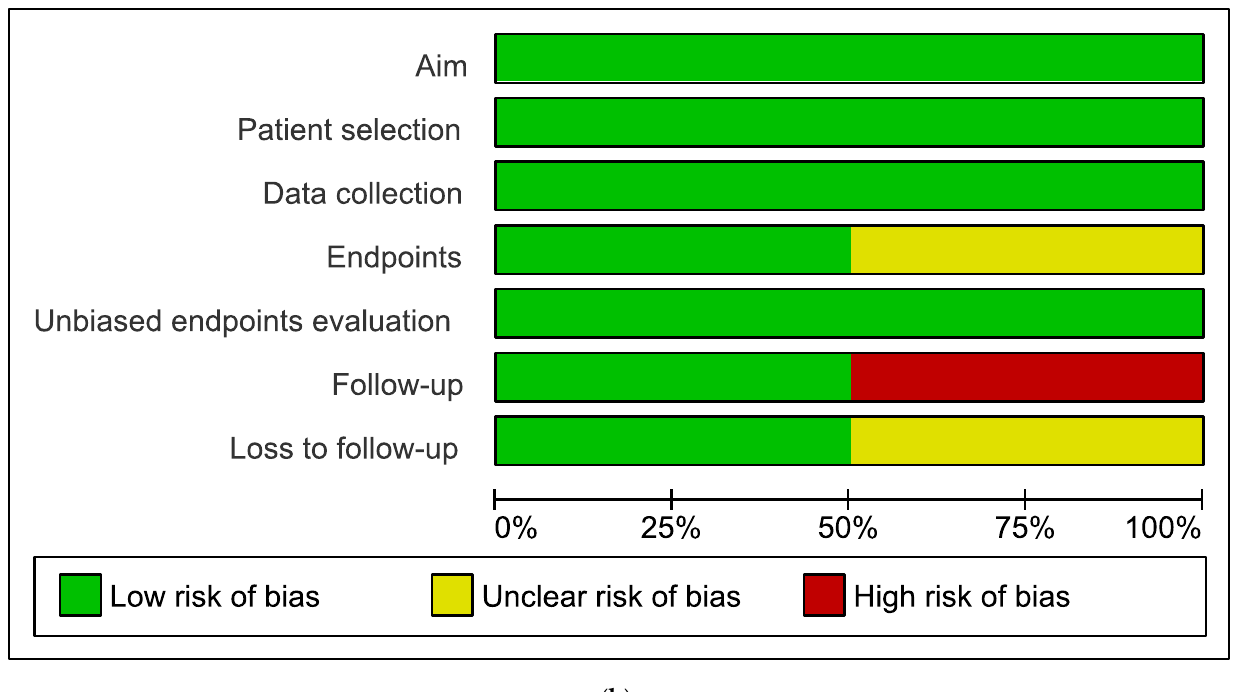
Figure 2. ( a ) Evaluation of the risk of bias within studies. Summary of the risk of bias in individual studies. Plus sign: low risk of bias; minus sign: high risk of bias; question mark: unclear risk of bias. ( b ) Risk of bias graph about risk of bias domains shown as percentages thorough all included studies.